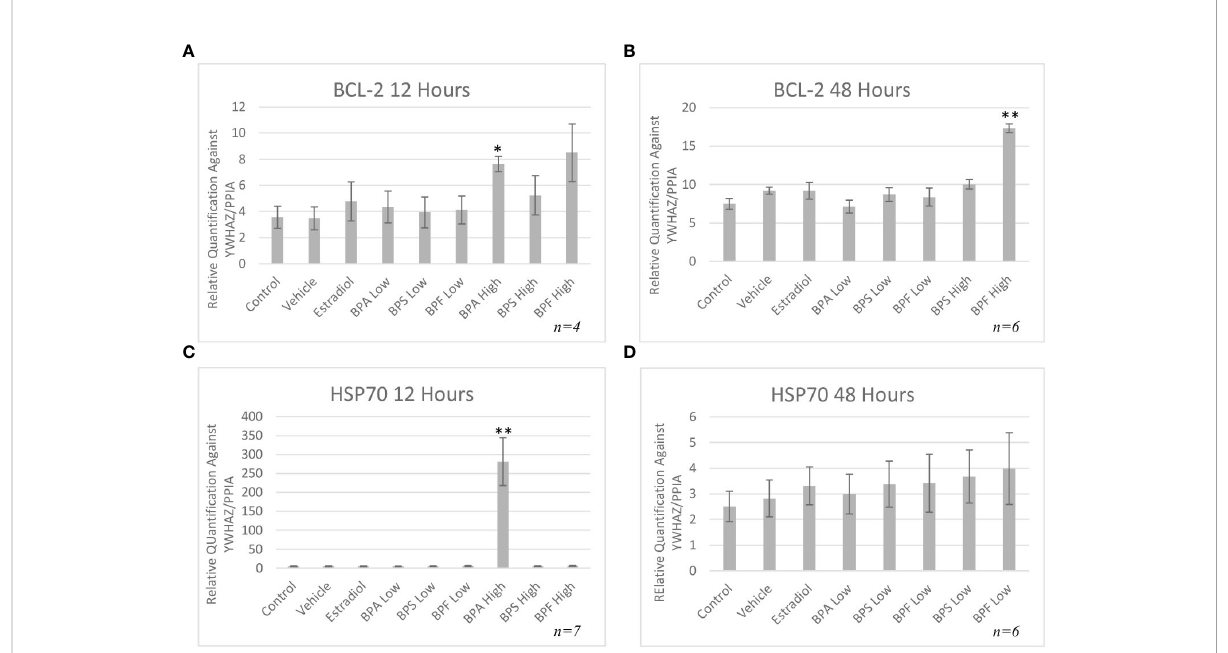
FIGURE 6 Anti-apoptotic mRNA expression after treatment with bisphenols. BCl-2 12 (A) and 48 (B) hours, and HSP70 12 (C) and 48 (D) hours in granulosa cells after treatment at a low (0.5 m g/mL) and high (50 m g/mL) dose of BPA, BPS, and BPF. Quanti fi cation relative to reference genes YWHAZ and PPIA. *p<0.05 and **p<0.01 compared to controls was considered as statistically signi fi cant. Error bars represent +/-